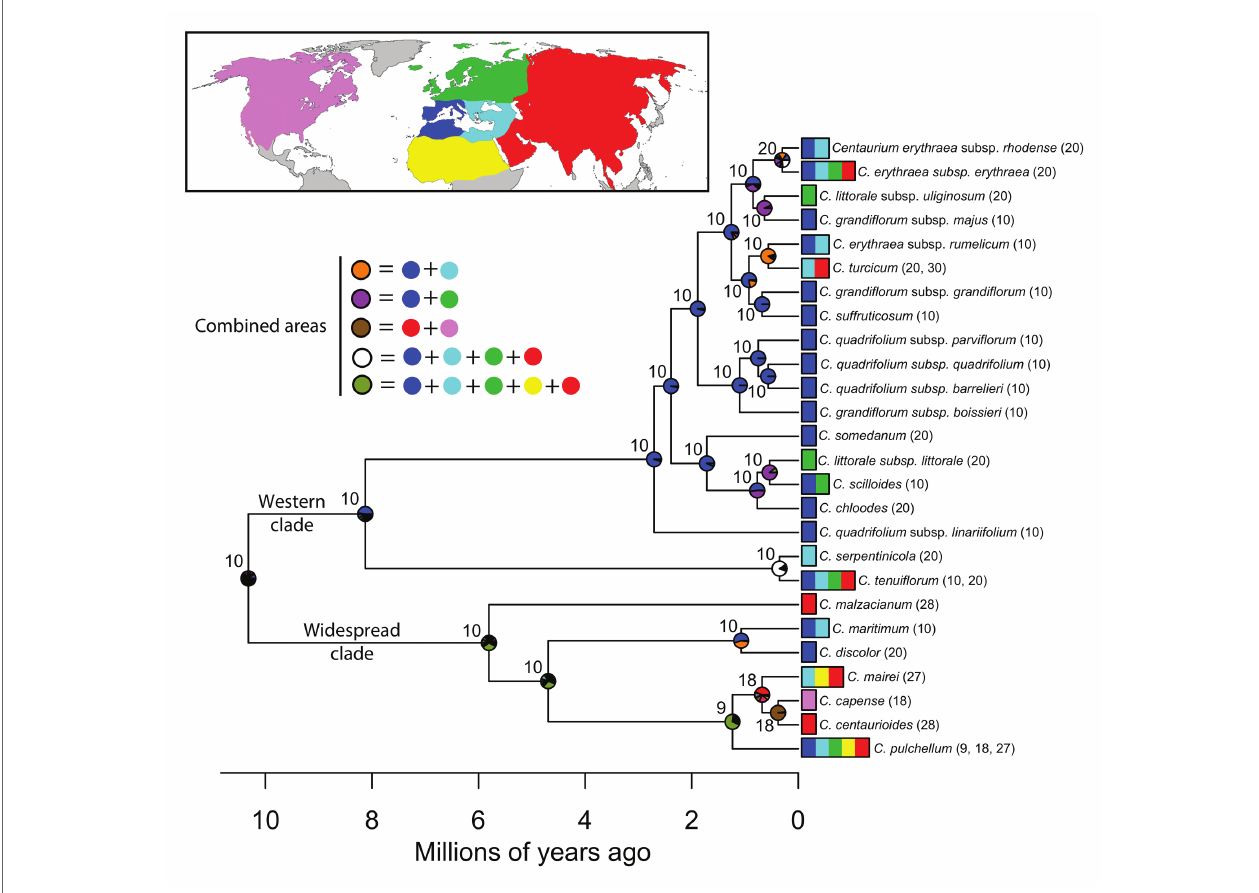
FIGURE 1 | Ancestral area reconstruction under constrained DEC model in Centaurium resulting from BioGeoBEARS analysis (Matzke, 2013). Node charts represent the probability of the occurrence of the most recent common ancestor (MRCA) of that node in the area represented by the same color on the map, and combined areas are represented by colors in the legend. Node numbers indicate the reconstructed haploid chromosome numbers retrieved by ChromEvol (Glick and Mayrose, 2014). Tip labels indicate species names and the area where each species occurs following colors in the map. Haploid chromosome number ( n , in parenthesis) and ploidy levels for the species are also indicated. Lower time-scale shows Millions of years ago, from the origin of the genus to the